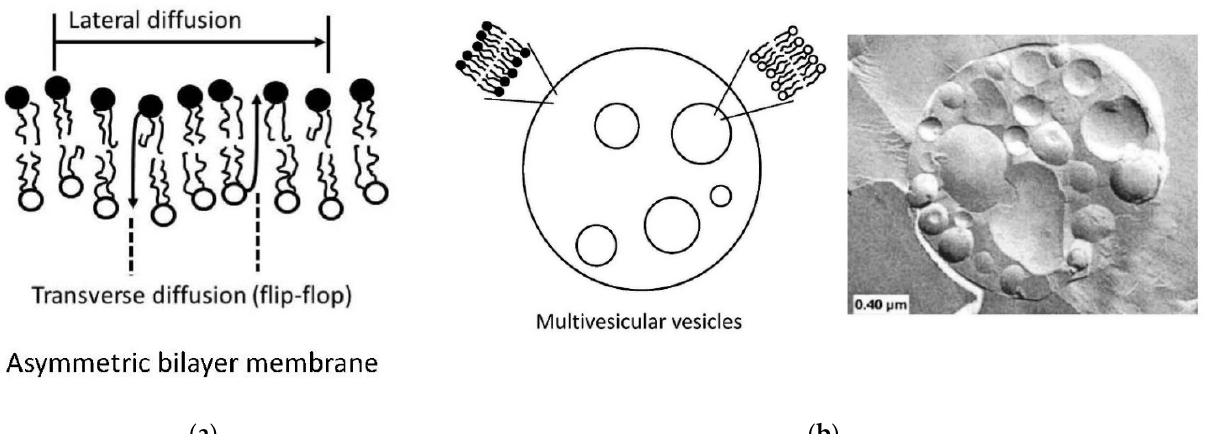
Figure 21. ( a ) Illustration of a section of a completely asymmetric fluid vesicle bilayer (with a high lateral lipid diffusion) built from a mixture of two different bilayer-forming amphiphiles (filled and empty polar head groups). Depending on Table 2019. [268]. ( b ) Freeze-fracture electron microscopy image of a multivesicular vesicle (MVV), consisting of an outer larger vesicle and many internal smaller vesicles (bar: 400 nm). A dispersion of such MVVs was prepared by heating a dispersion of interdigitated sheets prepared from DPPC/cholesterol (97.5:2.5, molar ratio) to T = 46 °C, as published by Kisak et al. (2002) [280]. Formation of the initial interdigitated sheet dispersion which occurred in the presence of 3 M ethanol; see also Giuliano et al. (2021) [281]. Reproduced with permission form [268], American Chemical Society, 2019; and from [280], American Chemical Society, 2002.